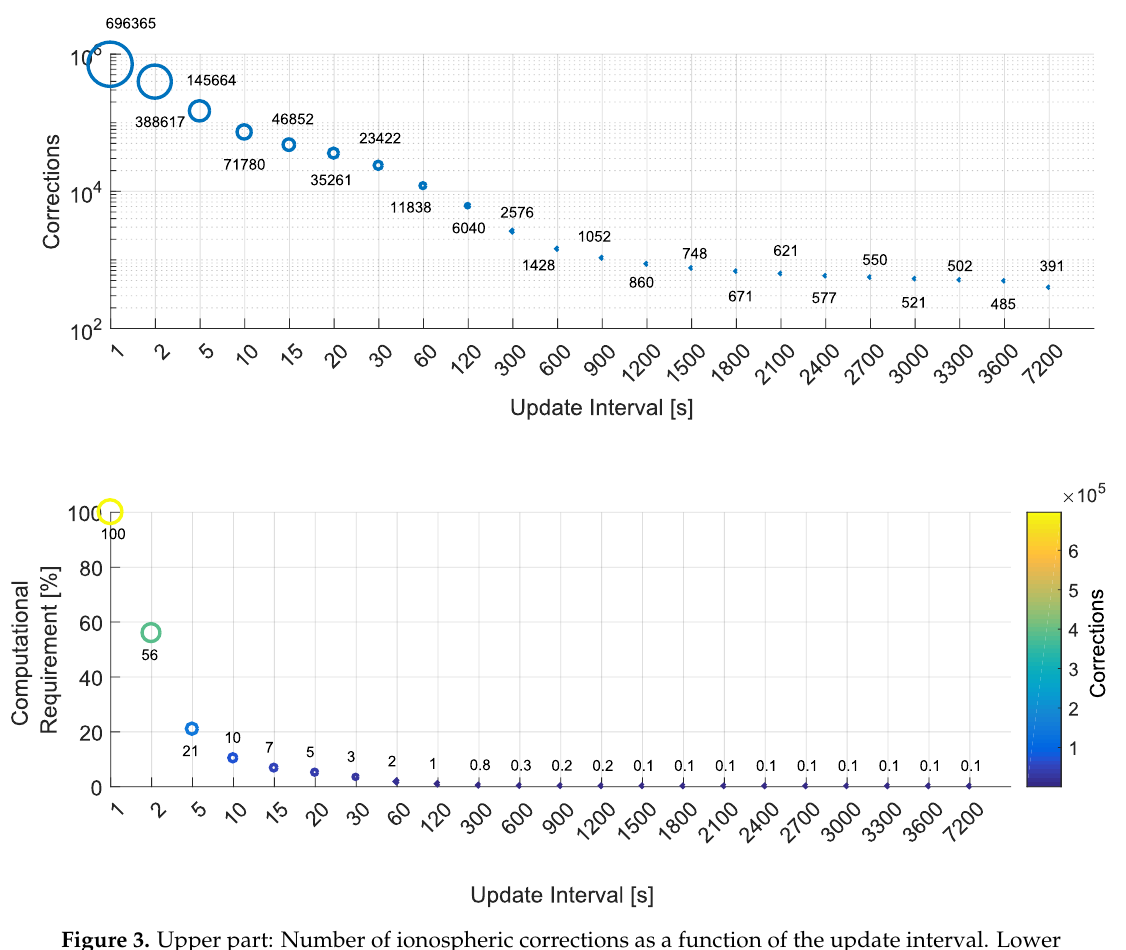
Figure 3. Upper part: Number of ionospheric corrections as a function of the update interval. Lower part: Computational requirements as a function of the update interval. An update interval equal to 1 is used as